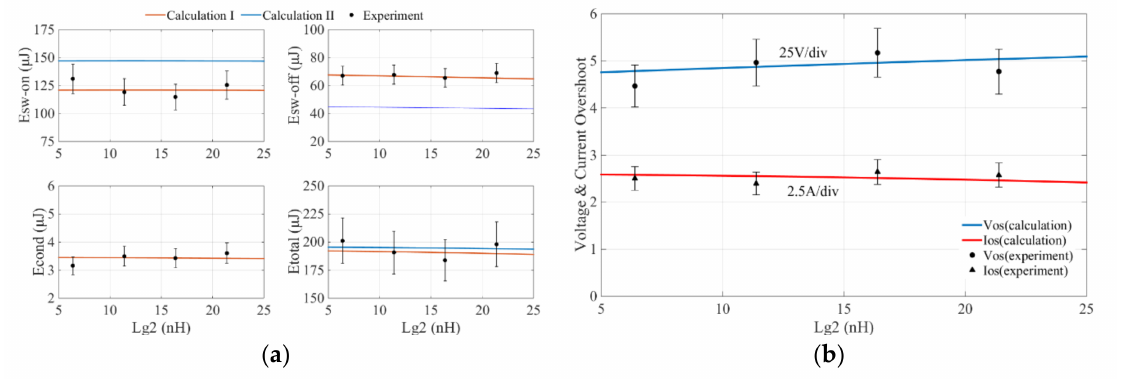
Figure 16. Comparison between experiment and calculation under the influence of external gate stray inductance L g2 . ( a ) Power losses. ( b ) Voltage overshoot and current overshoot.